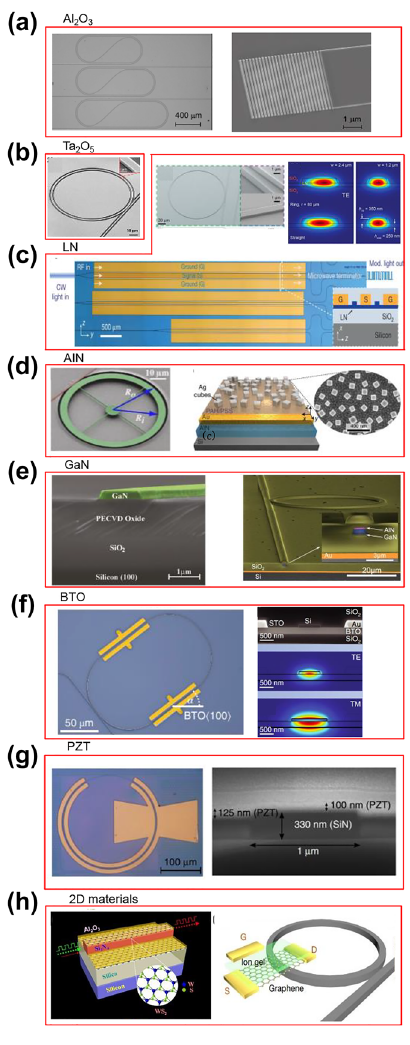
Figure 3: Representative devices of non-group-IV materials on silicon O : the SEMs of alumina straight, bent waveguides and platform. (a) AI 2 3 fully-etched grating couplers [90]. (b) Ta